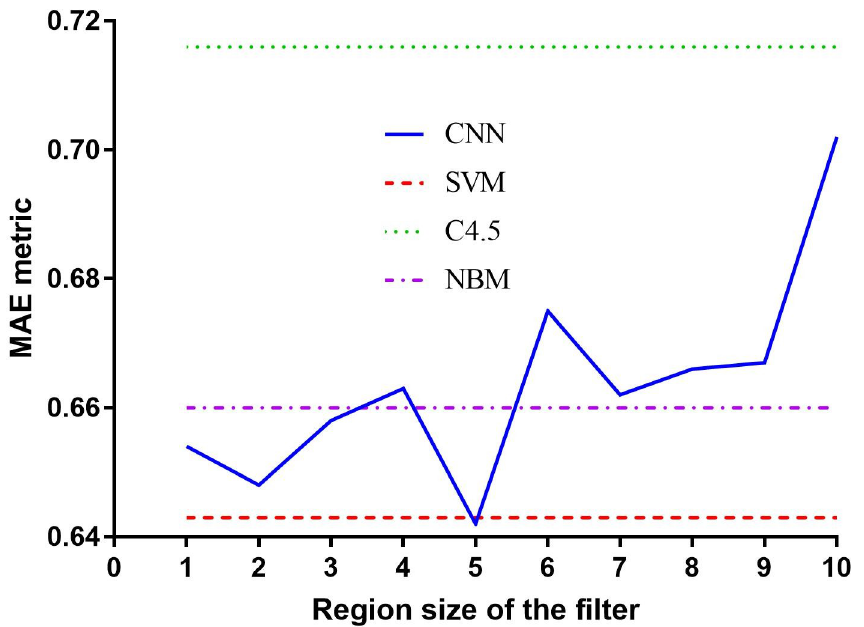
Fig 6. Performance comparison of CNN models with different region sizes and other baseline models.